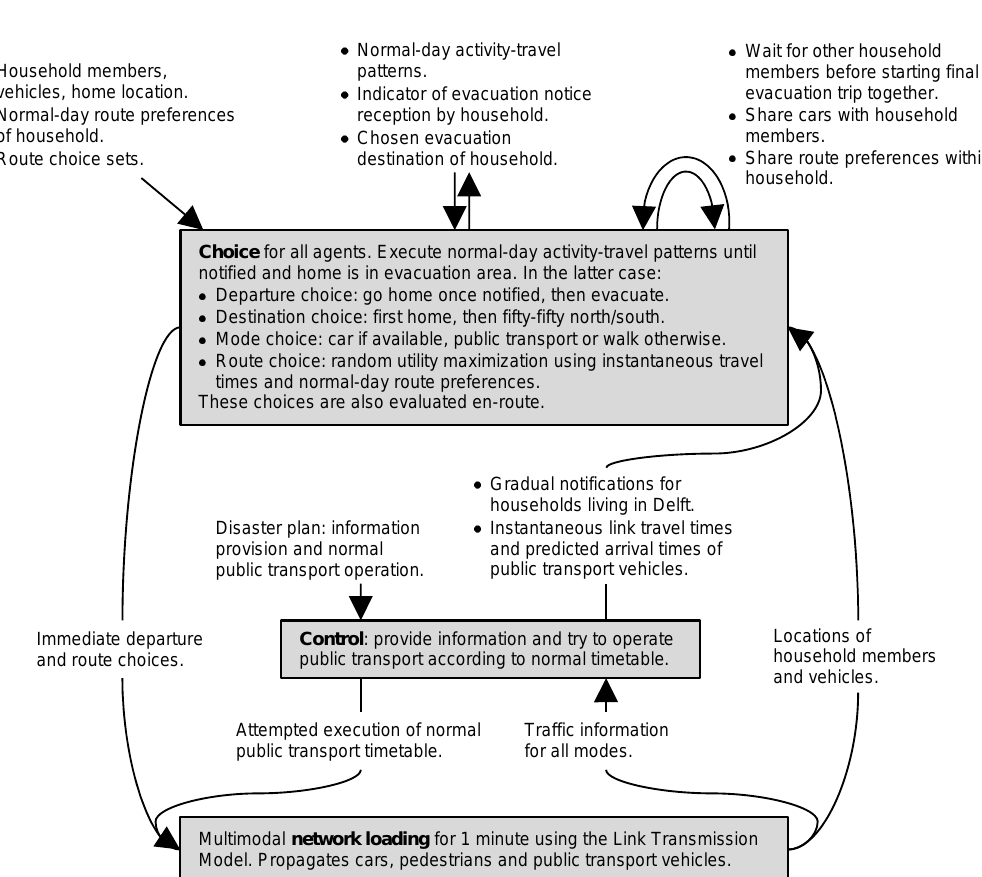
Figure 4. Overview of how the evacuation scenario implements the general framework of Figure